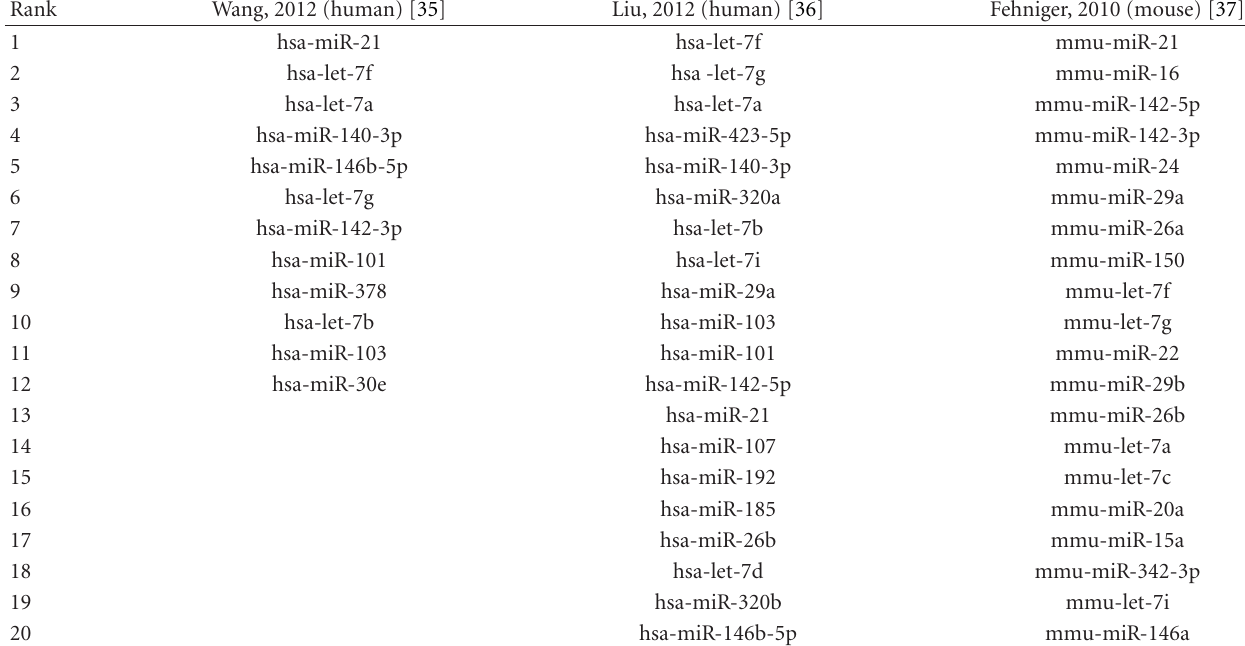
Table 1: Top expressed miRNAs in three studies, detected and enumerated by small RNA Illumina sequencing of resting human CD56 + CD3 −